Question: What does this figure show? Answer in one sentence.
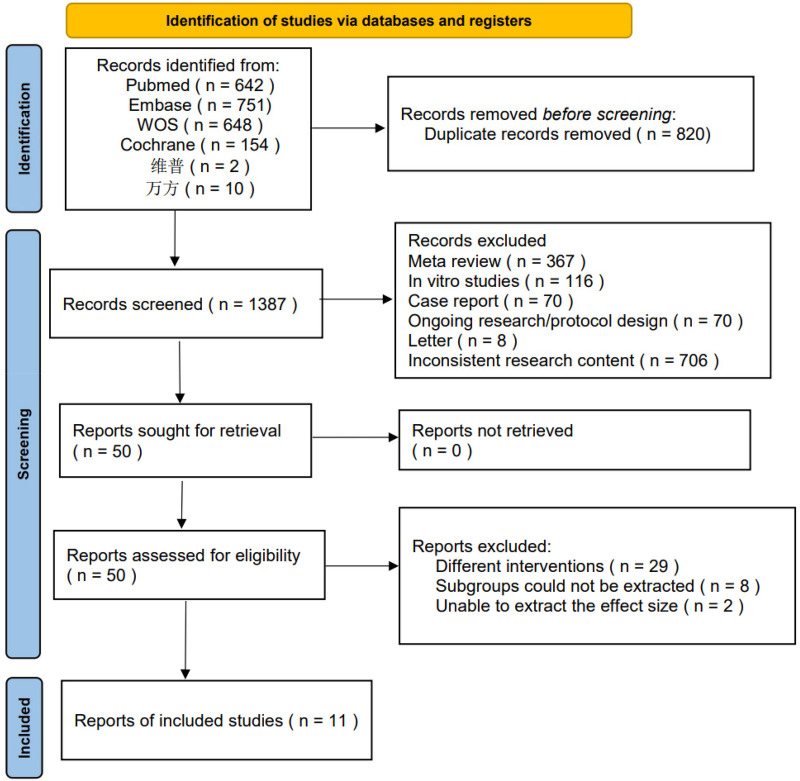
Answer: Summary of included studies and participant distribution.